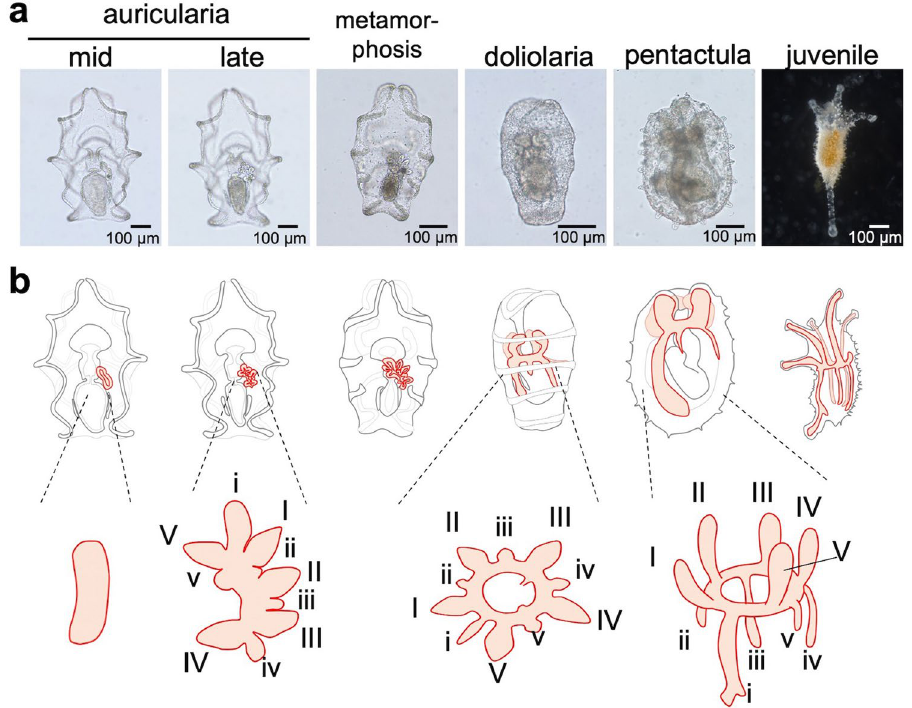
Figure 1. Normal development of the sea cucumber Apostichopus japonicus and schematic illustration of its hydrocoel. ( a ) The developmental process during auricularia larva and juvenile stages. Development proceeds from left to right. Auricularia, doliolaria, metamorphosis and pentactula are ventral views, anterior to the top, and juvenile is dorsal view, anterior to the top. ( b ) Schematic illustration of hydrocoel in each developmental stage. The orange part represents the hydrocoel or its derivative, i.e., the water vascular system. Auricularia and metamorphosing larvae are ventral views, and doliolaria, pentactula and juveniles are left lateral views, anterior to the top. The hydrocoel emerges on the left side of the archenteron in an auricularia, and 10 lobes are formed from the hydrocoel. After the lobe formation, the hydrocoel becomes horseshoe-like shaped to form a ring canal surrounding the digestive tract. Then, the larva metamorphoses into a doliolaria. Five of the lobes (I–V) extend anteriorly and become the water vascular canals of the tentacle of a juvenile, and another five lobes (i–v) are formed between the water vascular canals of the tentacle extend posteriorly and become radial canals. The numbering identities for hydrocoel lobes are based on the application of Loven’s axis to sea cucumbers 14